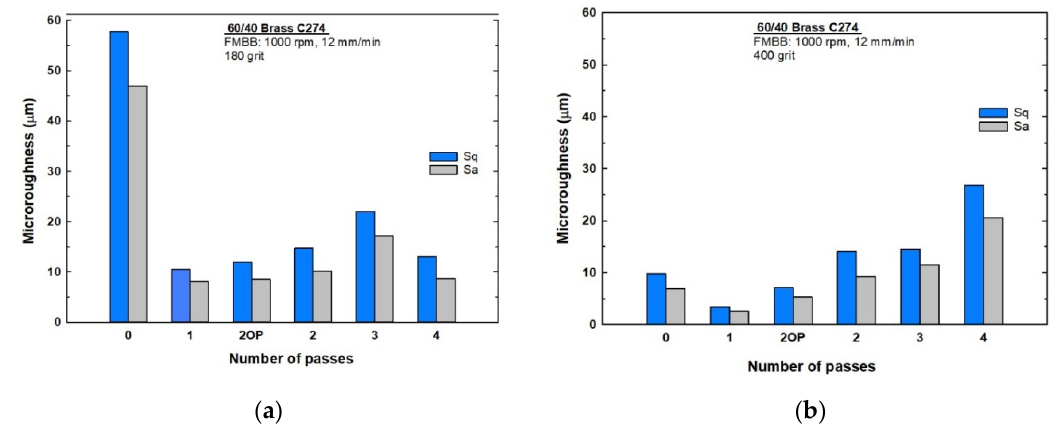
Figure 8. Microroughness results (Sa and Sq) for samples ground with ( a ) 180 grit and ( b ) 400 grit.